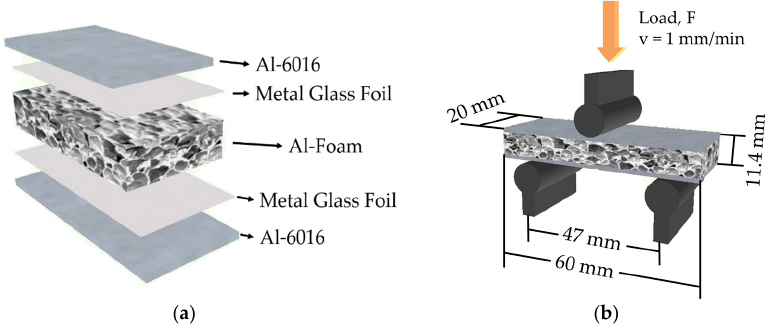
Figure 2. ( a ) AFS composite stacking configuration, and ( b ) the three-point bending (flexural) test